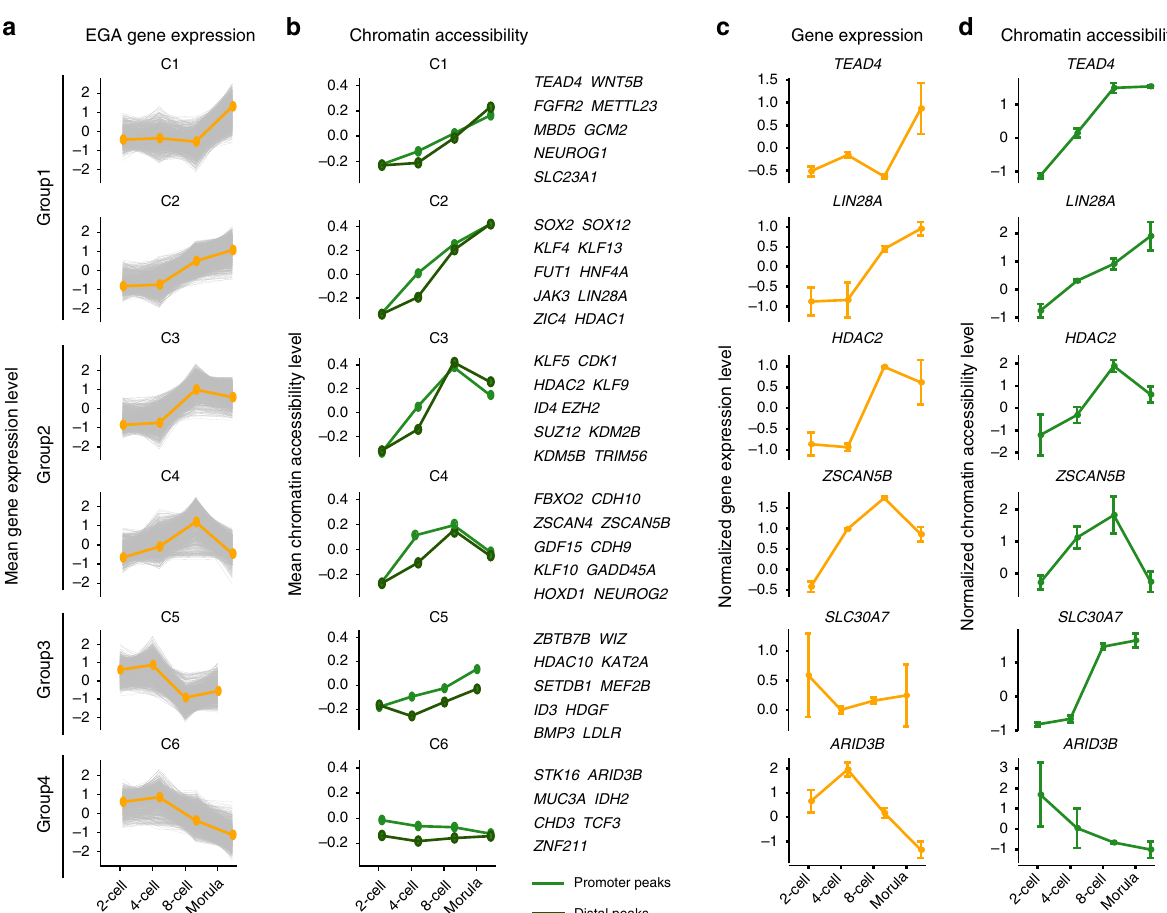
Fig. 2 Decomposition of gene expression and chromatin accessibility dynamics during embryonic genome activation. a Fuzzy clustering analysis of EGA gene expression signals for the indicated stages. The individual gray lines represent the expression level of individual genes, and the orange line represents the value for the cluster center. b Mean standardized chromatin accessibility of promoter peaks (light green) and distal peaks (dark green) for EGA genes in each cluster in a . Example genes for each cluster are listed in the right panel. c , d The dynamics of gene expression c and chromatin accessibility d for representative genes in each cluster. Source data used in this fi gure are provided as Supplementary Data 2. The error bars shown in this fi gure represent the mean ± standard deviation (SD) of two